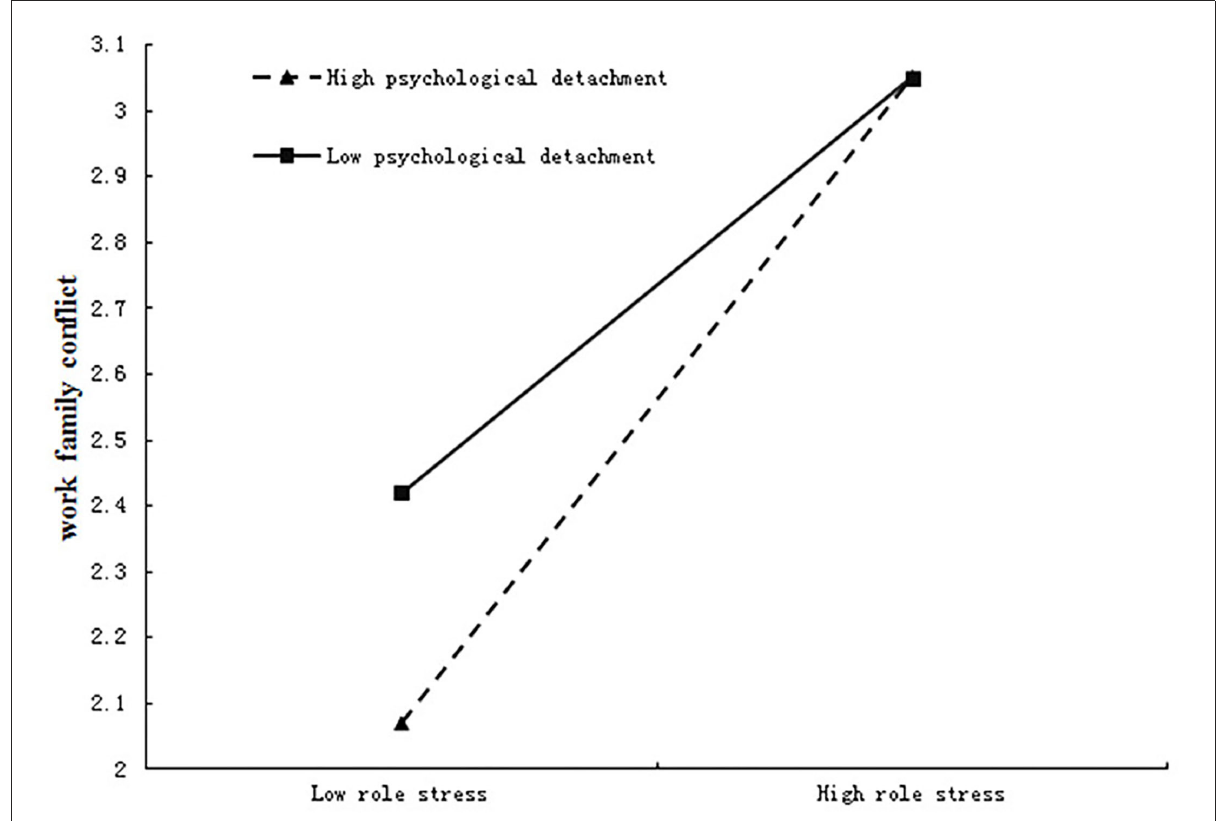
FIGURE3 Moderating effect of psychological disengagement between role stress and work–family conflict.